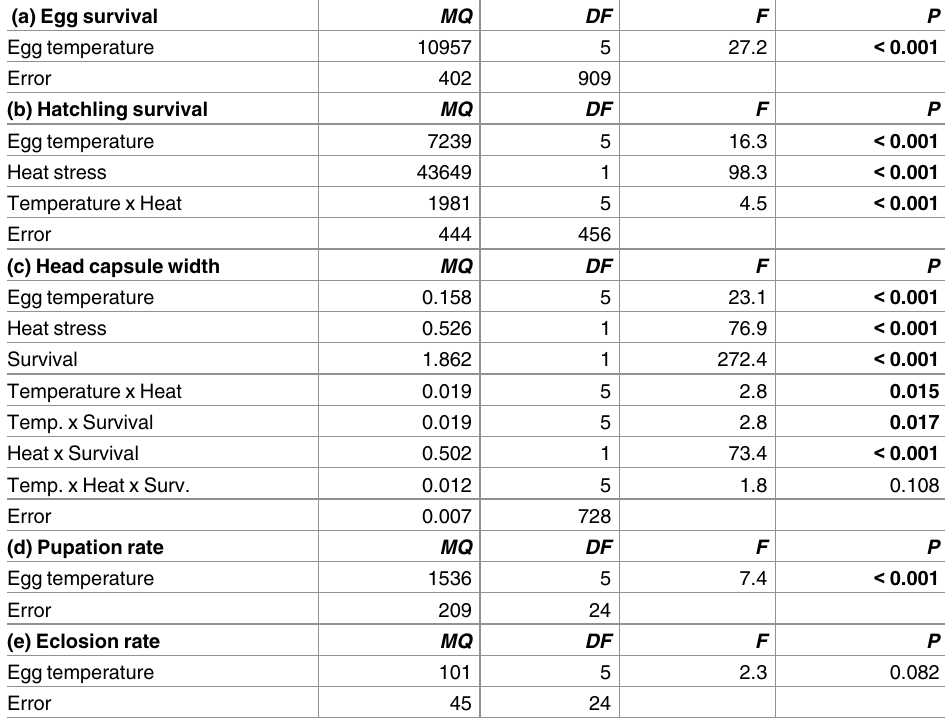
Table 1. Results of general linear models (GLMs) for the effectsof (a) egg temperature on egg survival rate, (b) egg temperature and larval heat stress on hatchling survival rate, (c) egg temperature, larval heat stressand survival (dead versus alive individuals) on head capsule width of hatchlings, and for the effectsof egg temperature on the survival rate during (d) the larval and (e) the pupal stage in Bicy- clus anynana . Significant P -valuesare given in